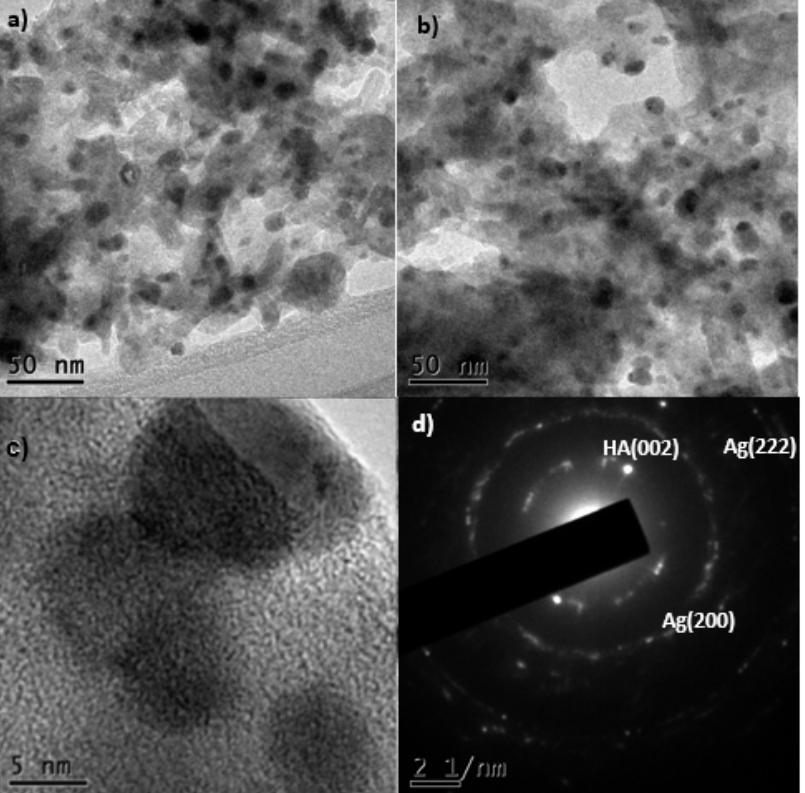
Figure 2. ( a ) and ( b ) TEM images of Ag nanoparticles (5%), ( c ) HRTEM, and ( d ) selected area electron di ff raction (SAED) images of Ag nanoparticles in bovine bone powder (5%), in di ff erent magnifications diffraction (SAED) images of Ag nanoparticles in bovine bone powder (5%), in different 120 kV. magnifications 120 kV.